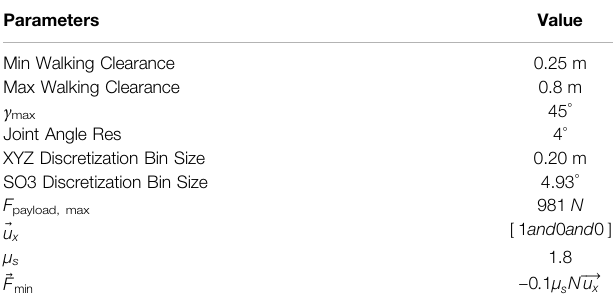
TABLE 2| Alistof fi xedparametersfortheoptimizationofthe16-DoFcontinuum- joint quadruped. Parameters